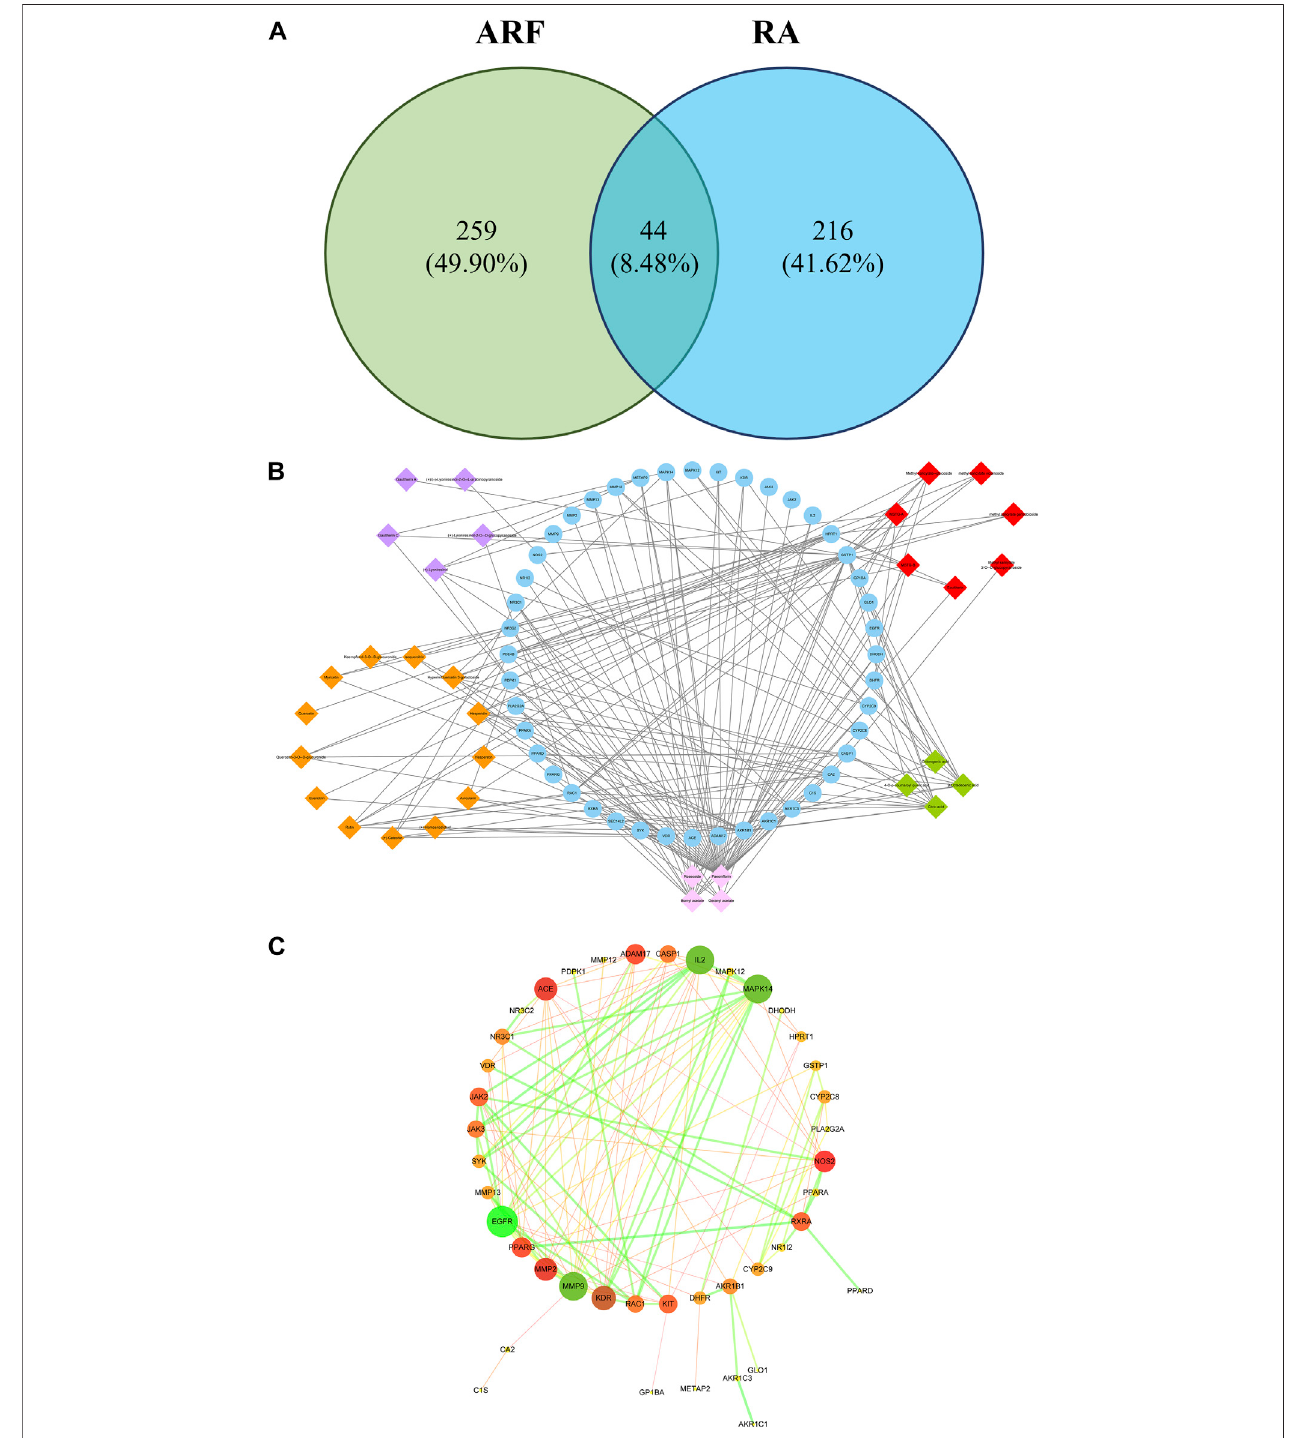
FIGURE6| ThenetworkanalysisofARFinvolvedinRAprogression. (A) Therelationshipofingredienttargetsanddiseasetargets.Thereare44overlappingtargets between RA and ARF. (B) The CCTN. The 33 diamond nodes indicate the active constituents of RA during drug treatment. The 44 blue nodes represent coincident targets between RA and ARF. The edges denote the association between nodes. The orange, red, purple, green, and light pink, respectively, represent fl avonoids, methyl salicylate glycosides, lignans, organic acids, and the other-class compounds. (C) The overlapping targets of PPI network of ARF. The color and size of the nodes are in directly proportion to DV, and the color and thickness of the bridge line are proportionate to the values of the combined score. The larger and darker the node, the more important position it occupied in this PPI network. The thicker and darker the edge, the stronger the interaction between the nodes.